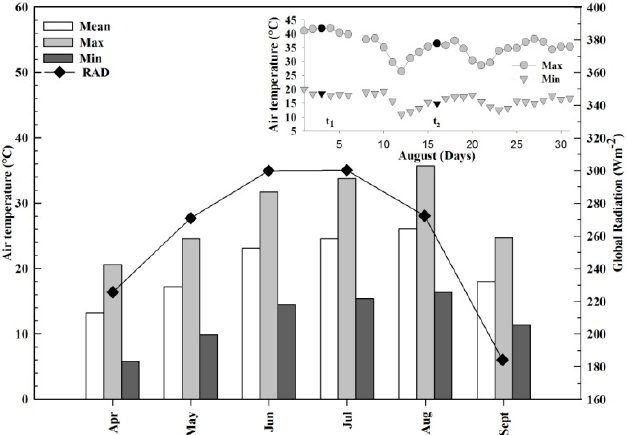
Figure 1. Climate parameters of the experiment location. Monthly averages of mean, maximum, and minimum air temperature ( ◦ C) and global radiation (RAD, W m − 2 ) measured from April to September; in the inset the daily averages of maximum and minimum air temperature ( ◦ C) measured in August are shown.